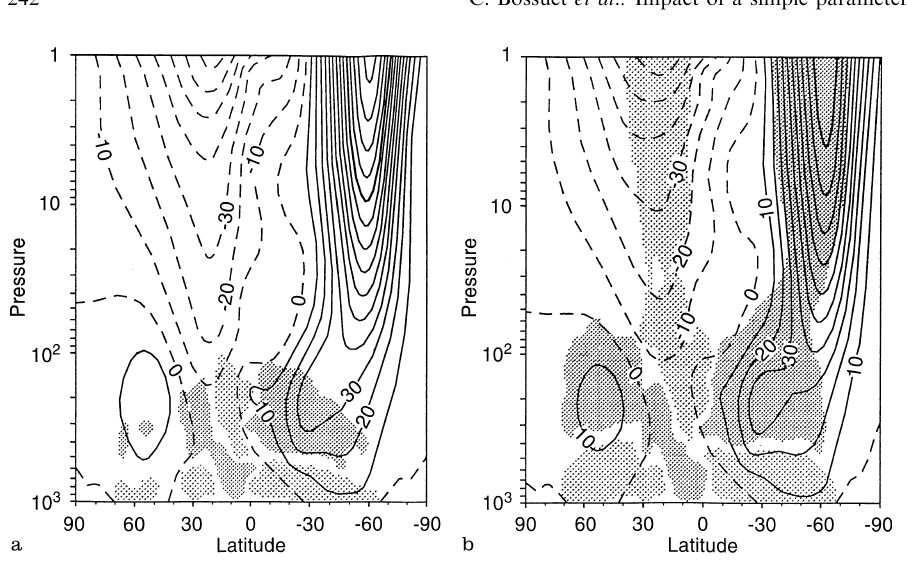
Fig. 3a, b. Zonal average of zonal wind response to the convective gravity-wave drag parameterization for a REF31 and b GWD31 for July. The dotted and solid contour lines (with 10-m s (cid:255) 1 interval) represent the zonal average of zonal wind, and the shaded values represent the zonal average of zonal wind tendency due to convection (m s (cid:255) 1 day (cid:255) 1 ). The light shading represents the positive values over 0 : 1 m s (cid:255) 1 day (cid:255) 1 and the